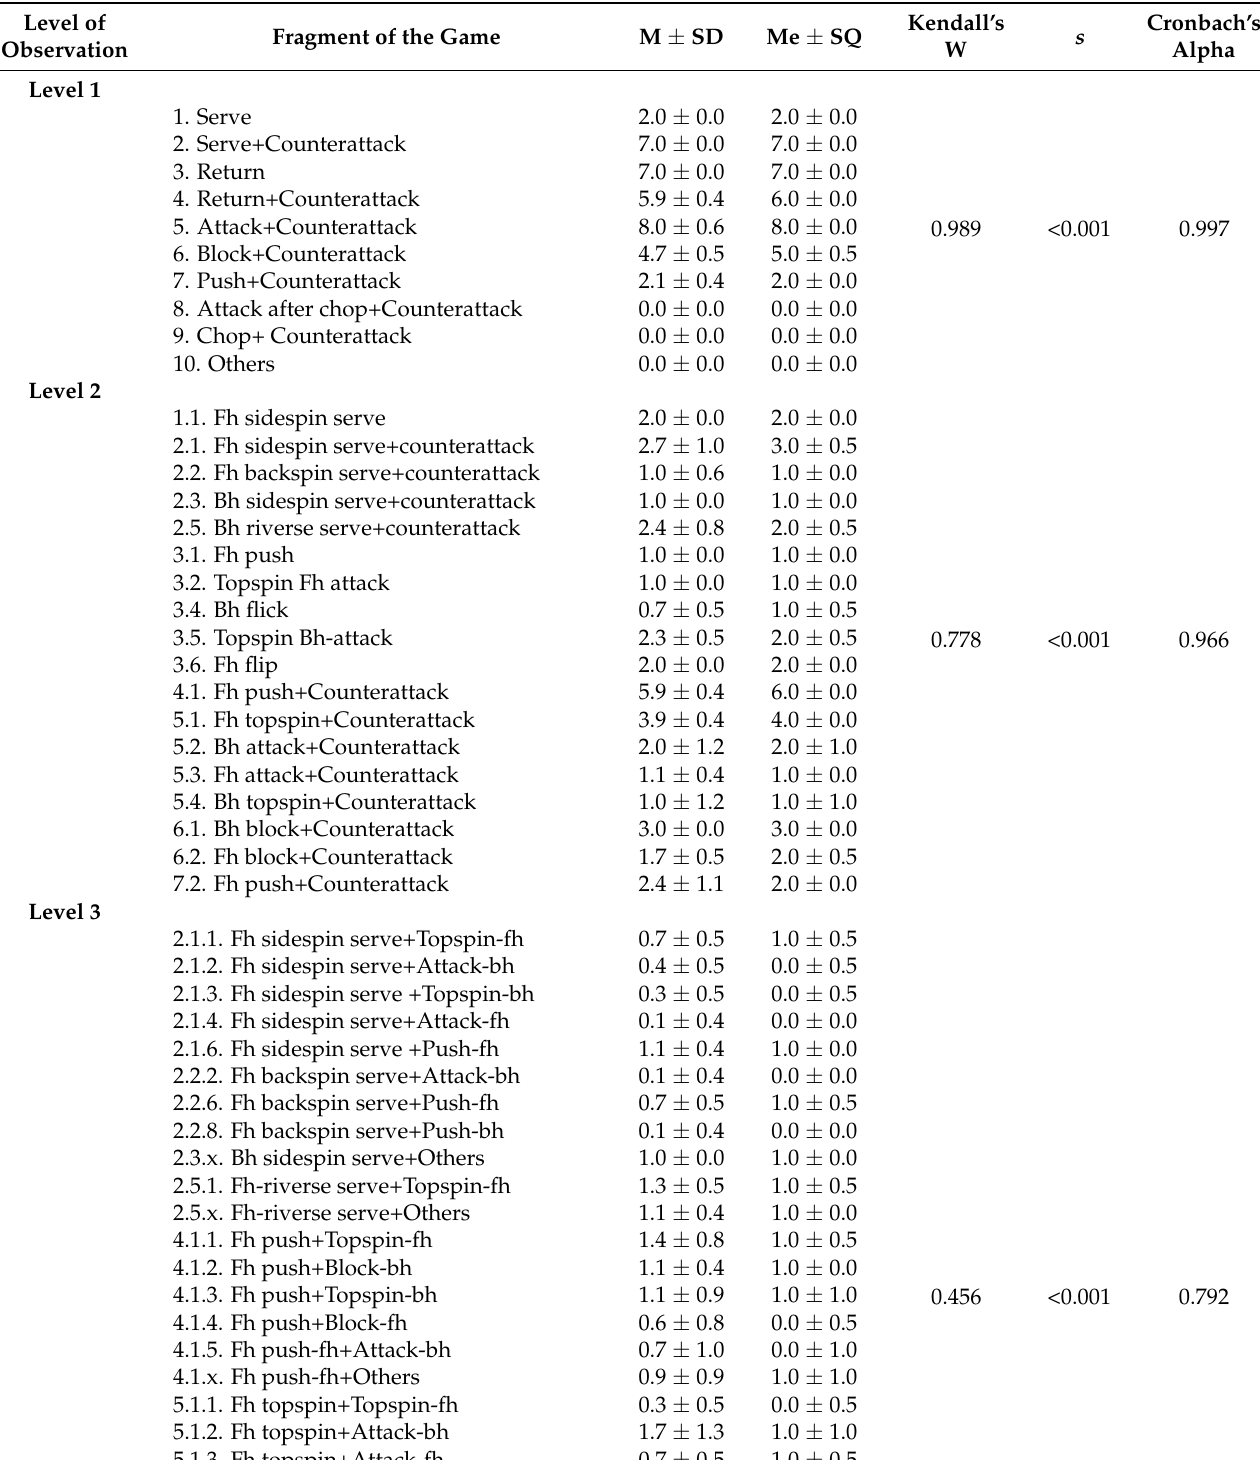
Table 3. Descriptive statistics and reliability assessment—the number of individual actions (game fragments) classified by experts (n = 7)—Mathias Falck’s